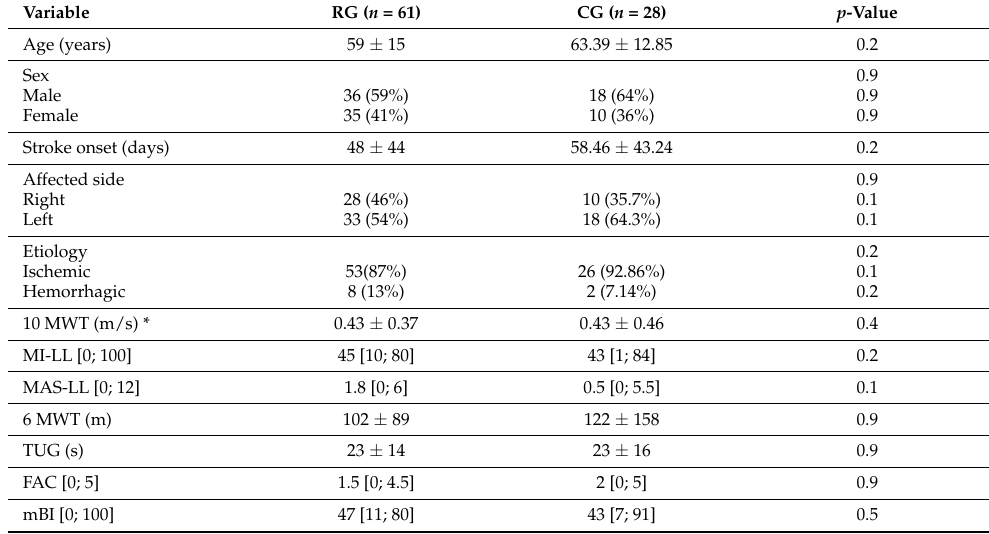
Table 1. Demographic and clinical characteristics of the Robotic Group (RG) and Control Group (CG) at baseline (T0).